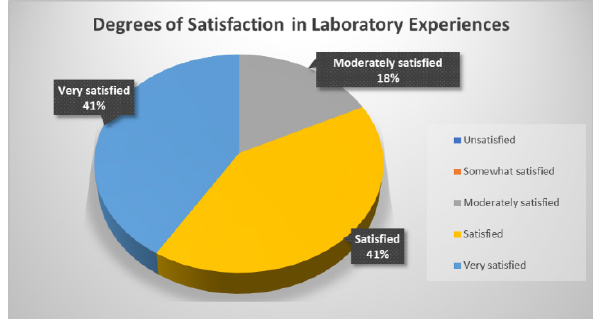
Fig. 16. Level of satisfaction in laboratory experiences with the new equipment purchased